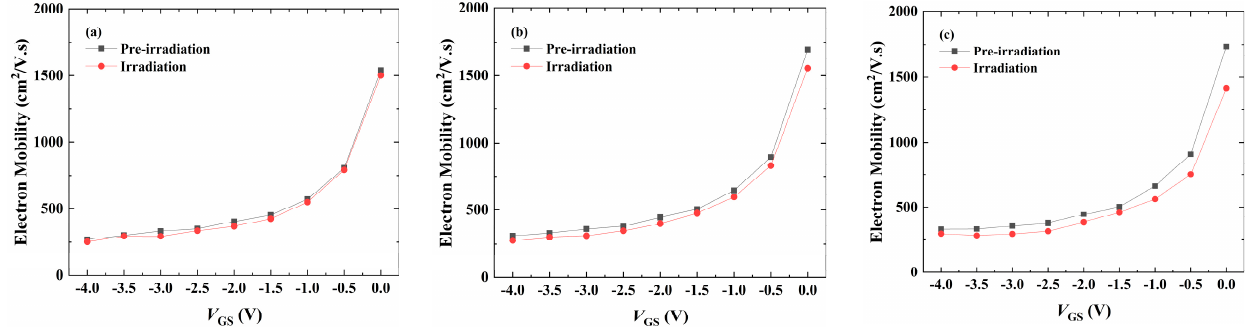
Figure 6. Gate–channel low- fi eld electron mobility µ n of Device 1 before (“Pre-irradiation”) and after (“Irradiation”) proton irradiation as a function of gate voltage with 1 MeV ( a ), 0.6 MeV ( b ), and 0.4 MeV ( c ) proton energies.